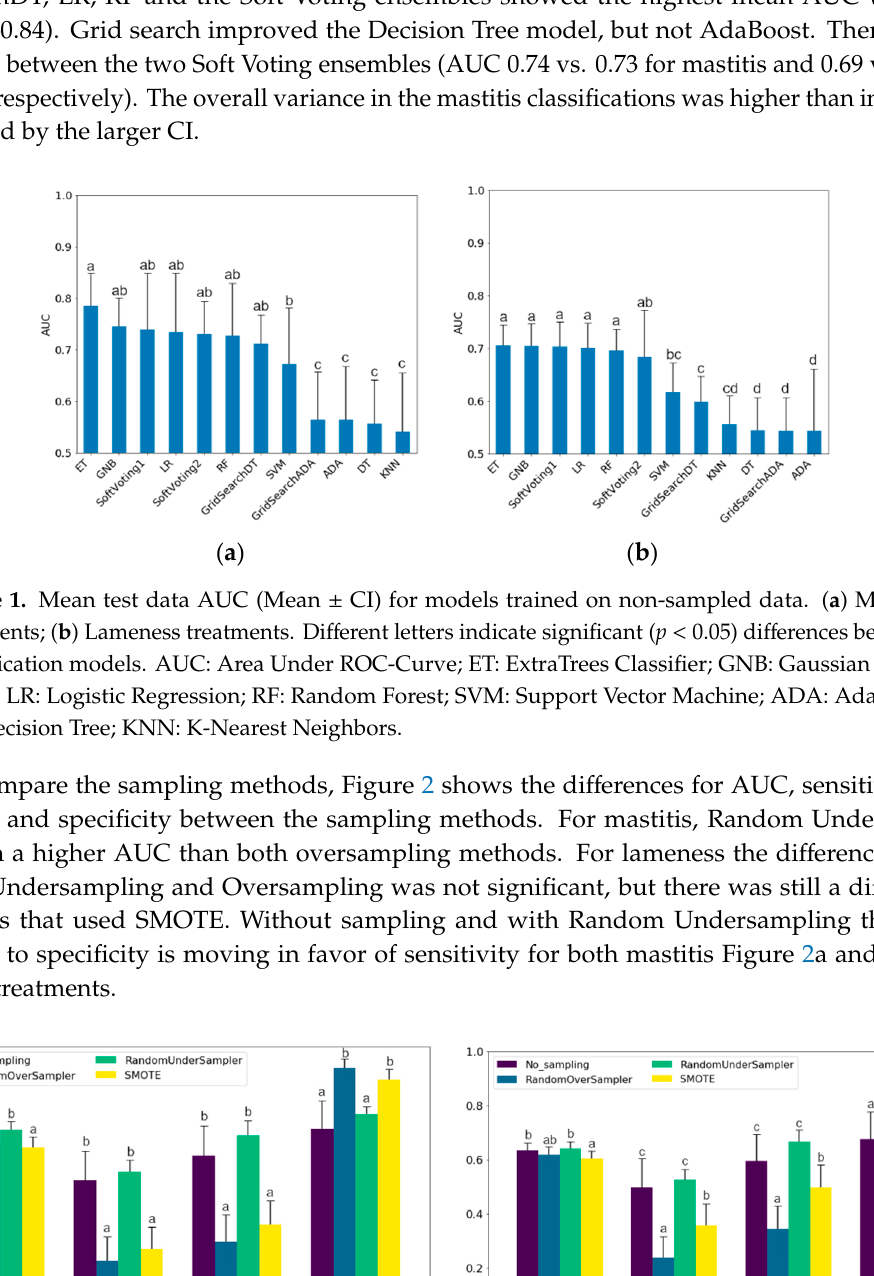
Figure 2. Mean test data AUC, Sensitivity, Block Sensitivity and Specificity (± 95%-CI) for each sampling method. ( a ) Mastitis treatments; ( b ) Lameness treatments. Different letters indicate significant ( p < 0.05) differences between sampling methods. AUC: Area Under ROC-Curve; SMOTE: Synthetic Minority Over-sampling Technique.